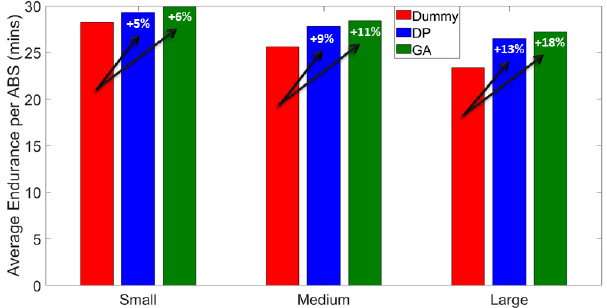
Figure 11. Average endurance per ABS with respect to different approaches under different scenarios